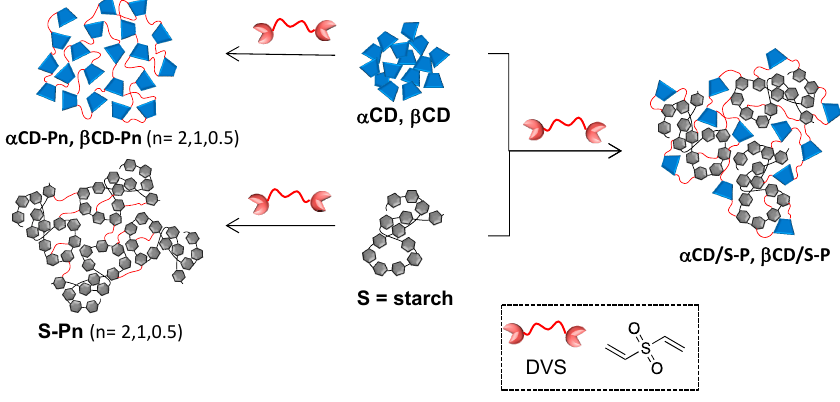
Scheme 1. Synthesis of DVS cross-linked homo- ( α CD-Pn , β CD-Pn , S-Pn ) and hetero-polymers ( α CD/S-P and β CDS-P ); n = stoichiometry DVS:Glc ratio: n = 2